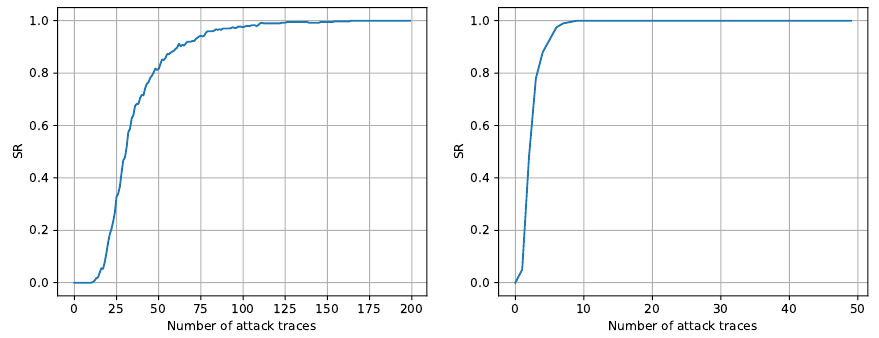
Figure 2: Baseline (left) and improved (right) attacks against an ARM Cortex-M0